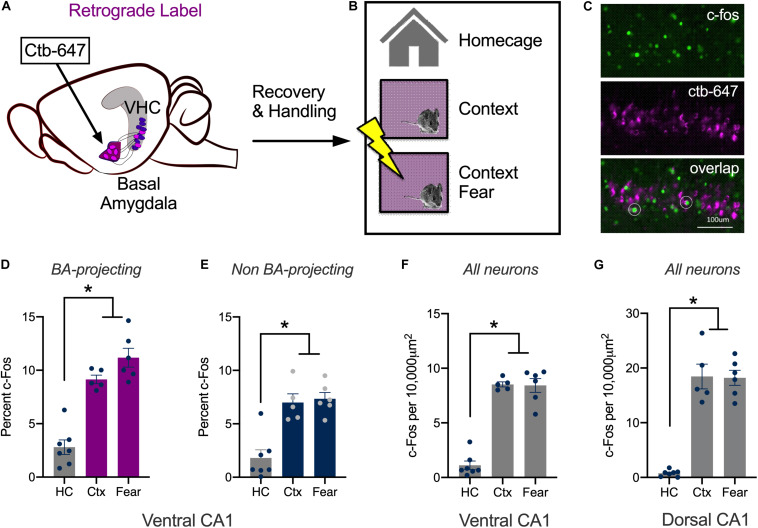
Context learning activates vCA1 neurons that project to the basal amygdala. (A–C) Experimental design. (A) Ctb (magenta) was injected into the BA. (B) Mice were sacrificed 90 min after exploring a novel context (Ctx) or undergoing context fear conditioning (Fear). Control animals remained in their homecages (HC). (C) Example histology showing c-Fos staining in green, Ctb labeling in magenta and overlap in BA-projecting neurons (right). (D,E) The percentage of BA-projecting (Ctb+) and non-projecting (Ctb−) vCA1 neurons that expressed c-Fos in HC, Ctx and Fear groups. (F,G) The number of neurons in ventral and dorsal CA1 that expressed c-Fos in HC, Ctx and Fear groups. Data are presented as mean ± SEM. *p < 0.05.